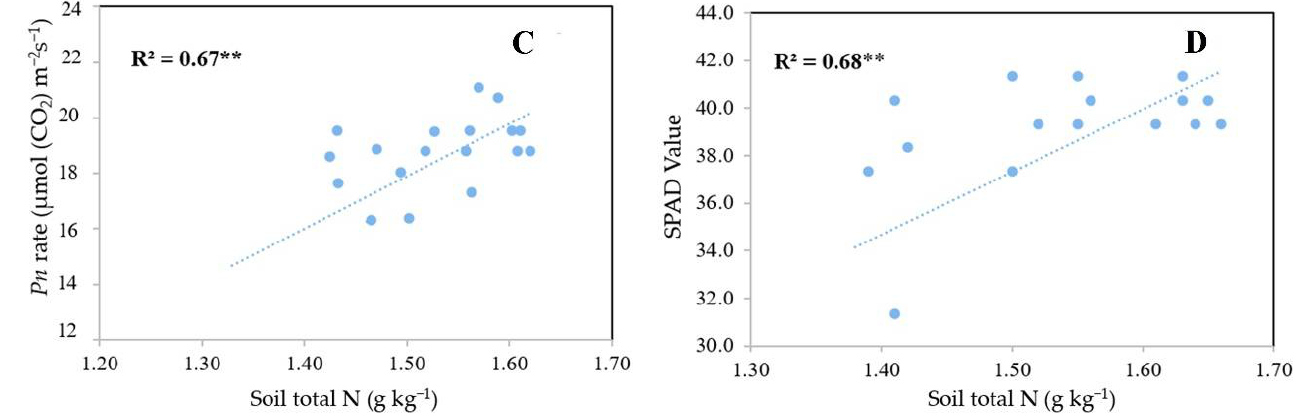
Figure 6. Linear regression analysis of soil organic C ( A , B ) and total N ( C , D ) with soil net photosynthetic rate and the SPAD values. **, *= significant at 5% and 1%, respectively. n = 18. In addition, we also performed a correlation analysis among the leaf physiological traits and rice grain nutritional attributes (Figure 7). The linear regression analysis revealed that grain nutritional traits, such as SC (R 2 = 0.50 *, Figure 7A) and AC (R 2 = 0.58 *, Figure 7B), were positively correlated with leaf Pn . Similarly, the grain nutritional traits, such as SC (R 2 = 0.60 *, Figure 7C) and AC (R 2 = 0.61 *, Figure 7D), were positively correlated with the leaf SPAD values. Moreover, the heatmap correlation analysis revealed a positive correlation among the soil properties (SOC, TN, and AN), leaf physiological traits ( Pn and SPAD values), grain nutritional attributes (SC, AC, and PC), and starch RVA profile features (PV, TV, FV, SB, and PT) (Figure 8). The linear regression analysis results confirmed that the increases in soil nutrient content, particularly in SOC and TN, described the highest proportion of the difference in the leaf physiological activities. Hence, changes in leaf physiological activities are closely associated with rice grain nutritional traits.